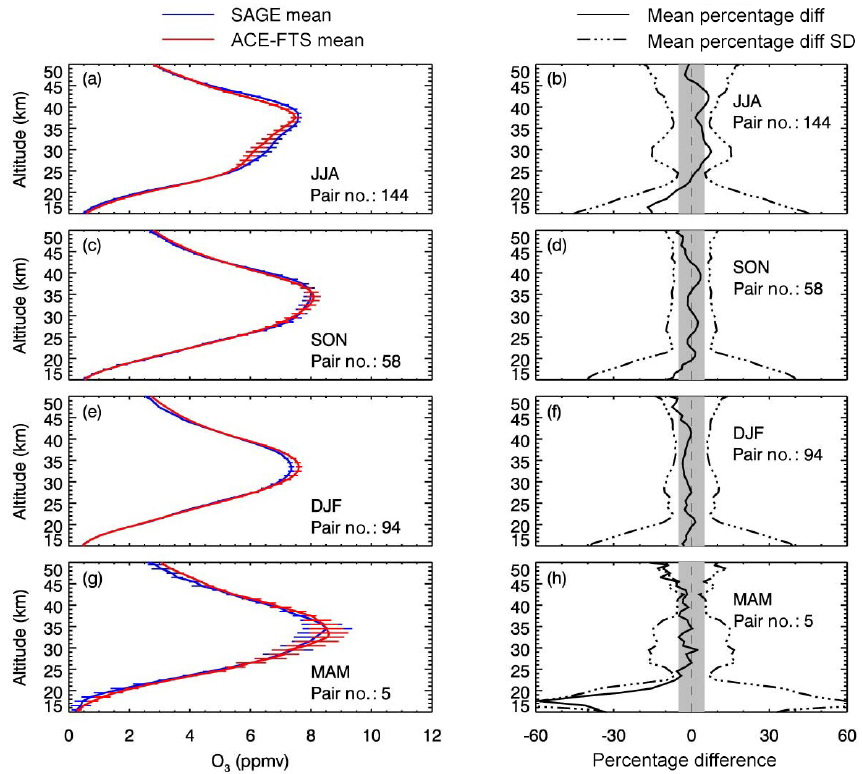
Figure 8. Seasonal average ozone mixing ratio profile comparisons between coincident SAGE III-ISS and ACE-FTS measurements for the Southern Hemisphere under the criteria of a latitude difference of less than ± 10 ◦ , a longitude difference of less than ± 20 ◦ , and a time difference of less than ±